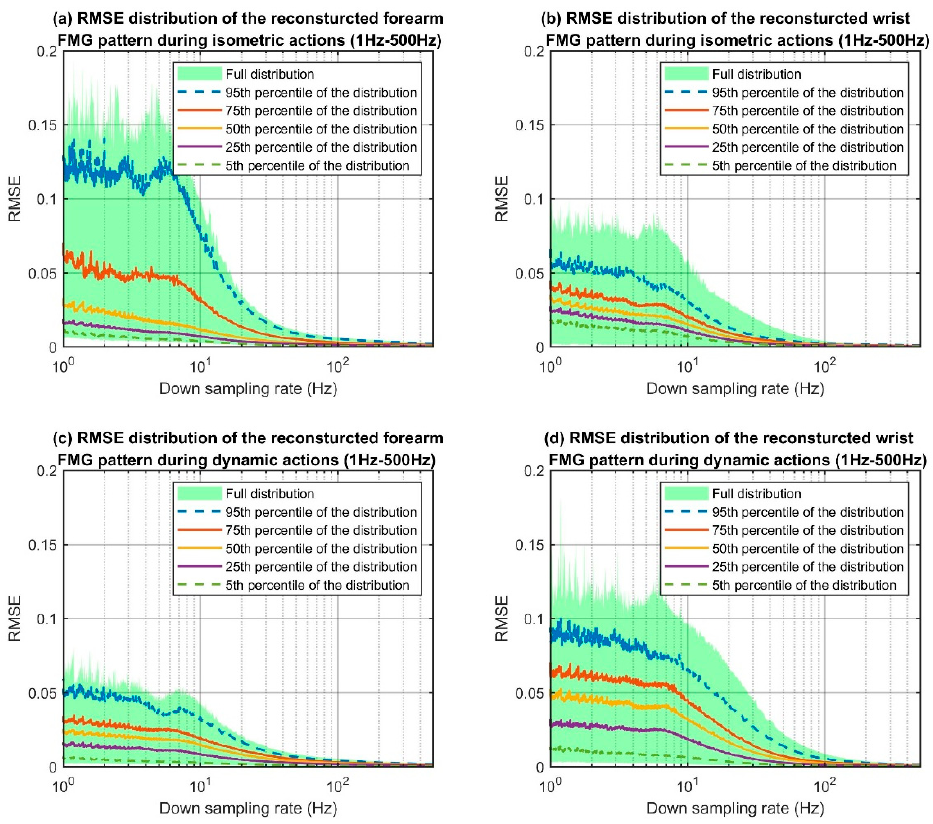
Figure 6. RMSE distributions of different resampling frequencies.